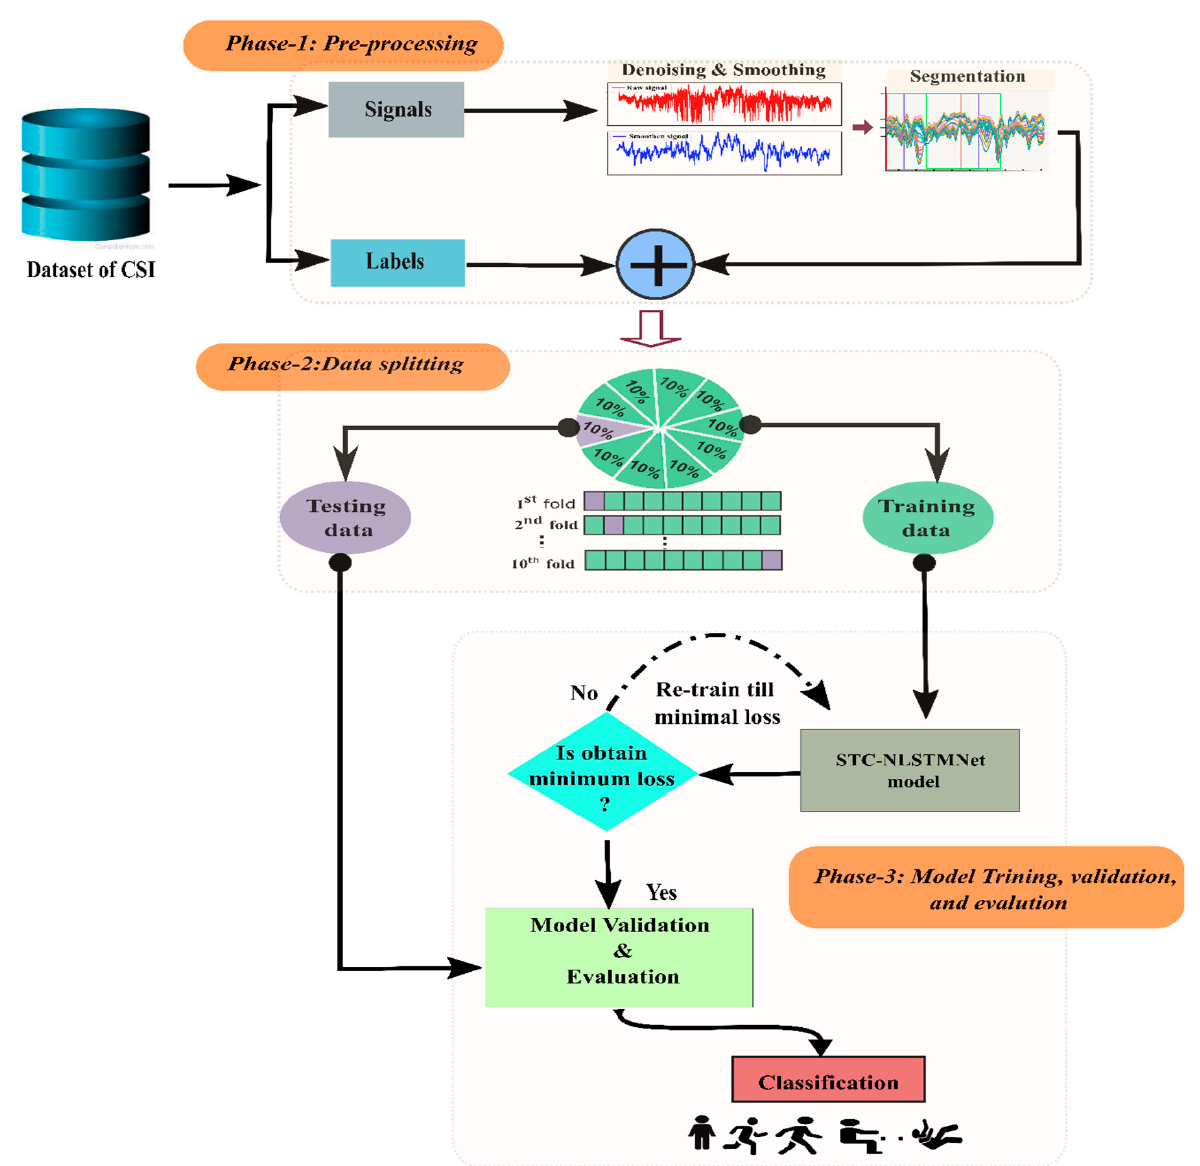
Figure 1. Block diagram of procedural steps of the proposed STC-NLSTMNet model to recognize human activity.